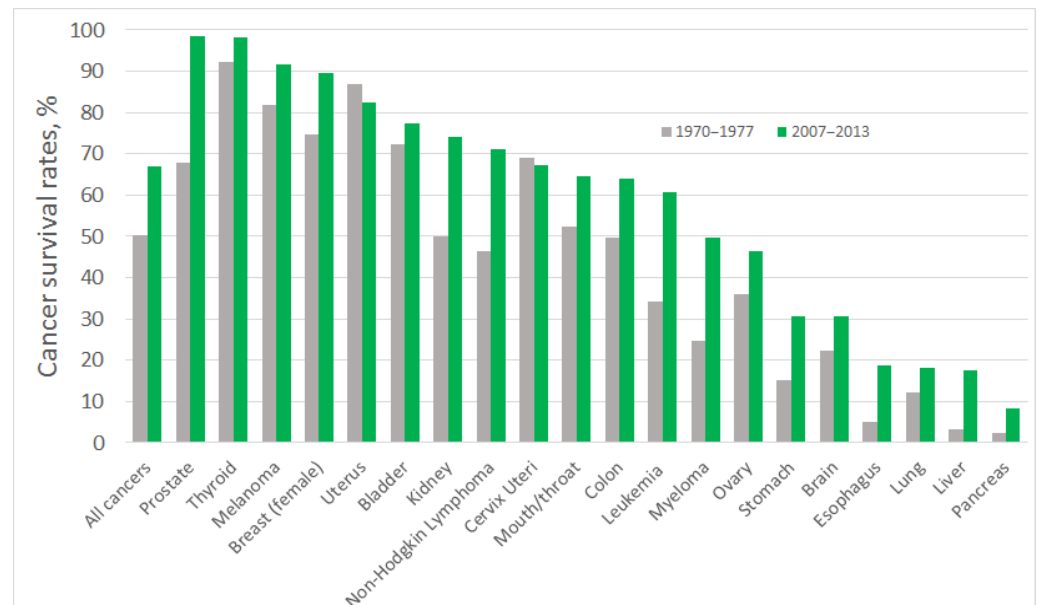
Figure 1. Five–year cancer survival rates in the USA, shown as the rate over the period 1970–1977 (grey bars) and 2007–2013 (green bars). The five–year interval indicates the percentage of people who live longer than five years following the diagnosis, data were taken from [7].